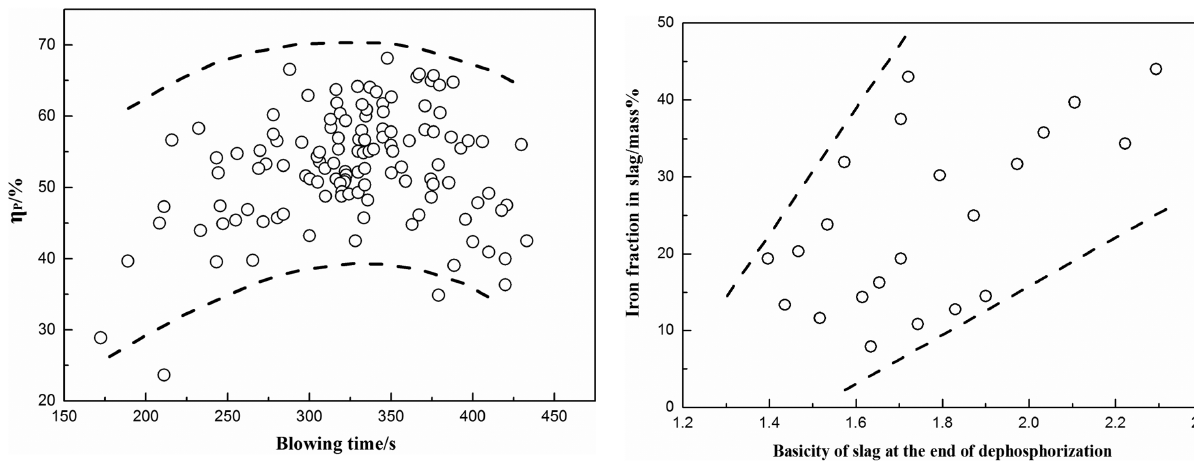
Figure 7: Effect of blowing time on dephosphorization ratio. Figure 8: Relationship between iron fraction in slag and slag basi- city at the end of dephosphorization.